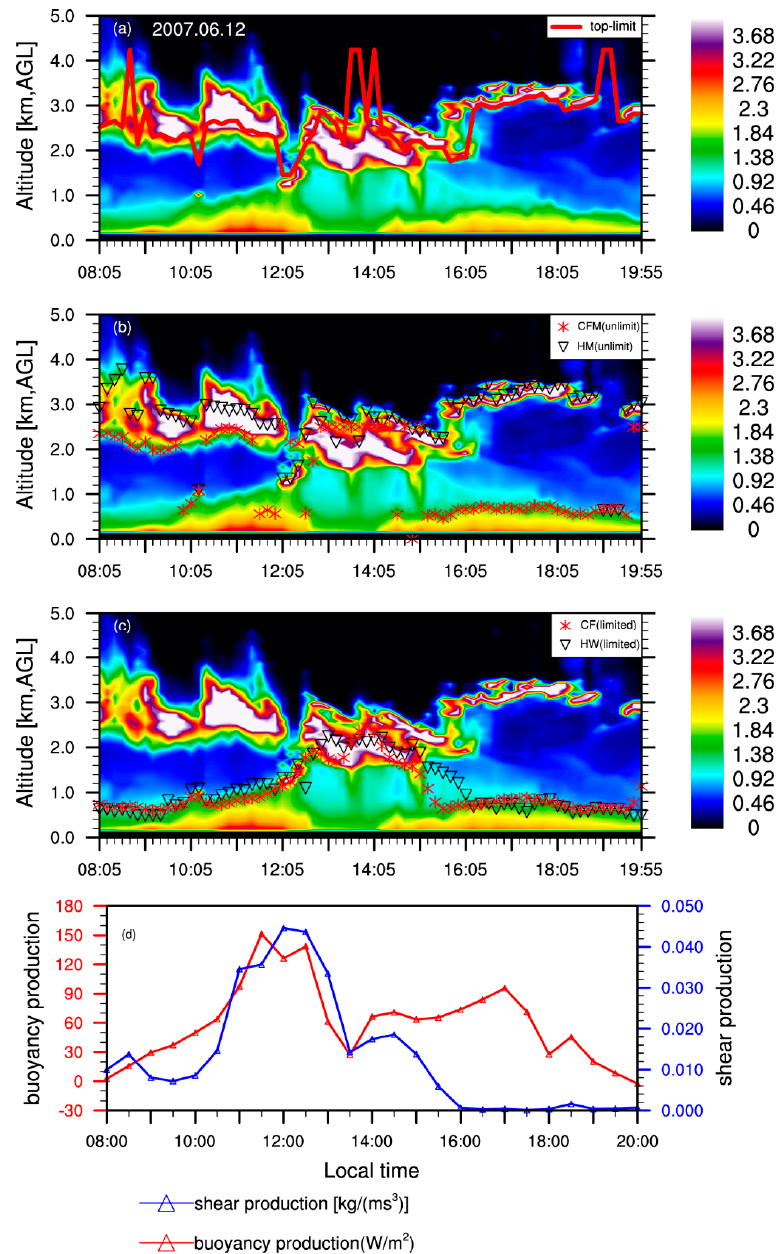
Figure 12. Same as in Figure 9, but on 12 June 2007. The radiometrics profiling radiometer data quality were seriously affected by clouds and there was no equivalent potential temperature data available. Above all, the elevated aerosol layers, such as RL in the early morning as well as cloud layers,